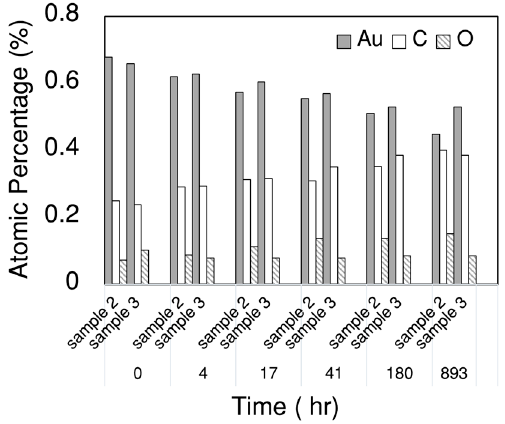
Figure 4. The sample stored in a desiccator (sample 3) allowed adsorption of fewer VOC molecules—a higher atomic percentage of Au—on its surface, as compared to the samples left in an open environment (sample 2) by desorbing the part of VOCs that has double oxygen bonds.